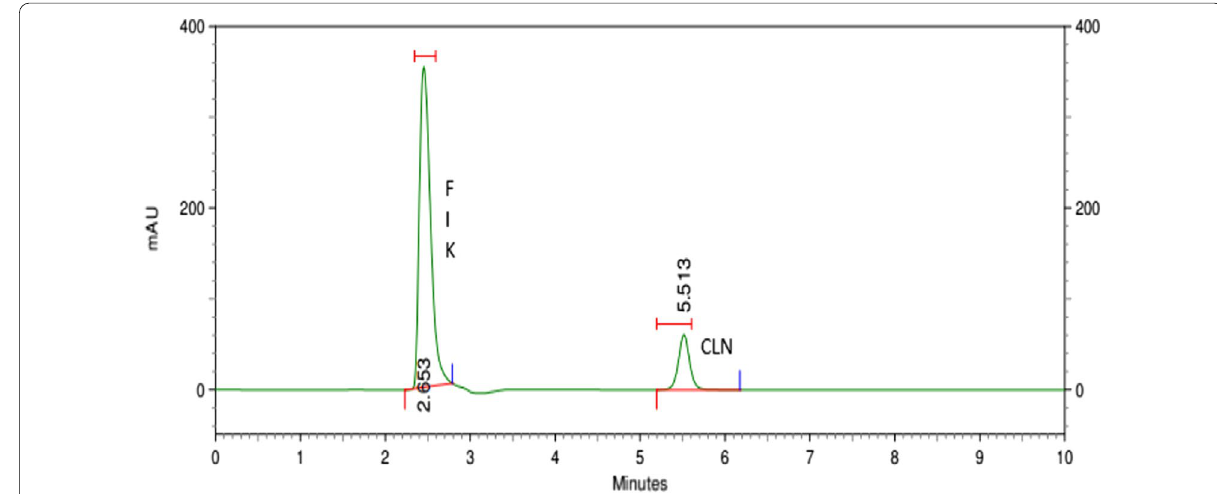
Fig. 3 Optimized chromatogram